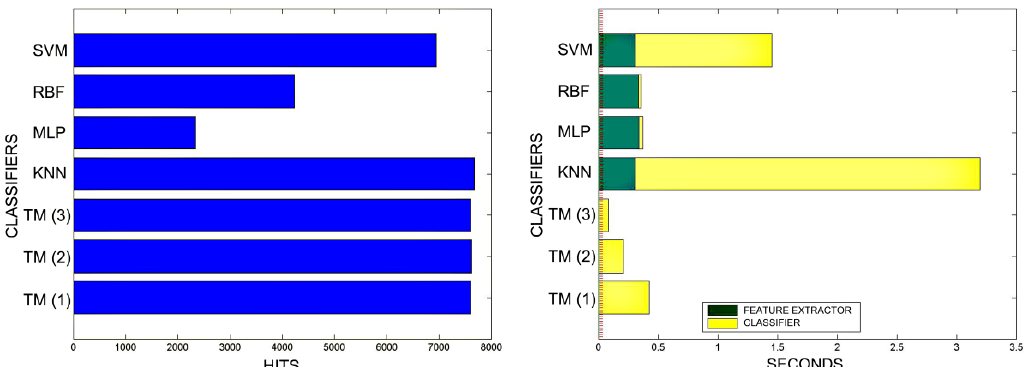
Figure 22. Comparison of successful matches on the left, in blue, and time taken for classification on the right, feature extractor in green, and classification in yellow. In descending order, the training sets represent 80%, 90%, and 100% of the total training samples.